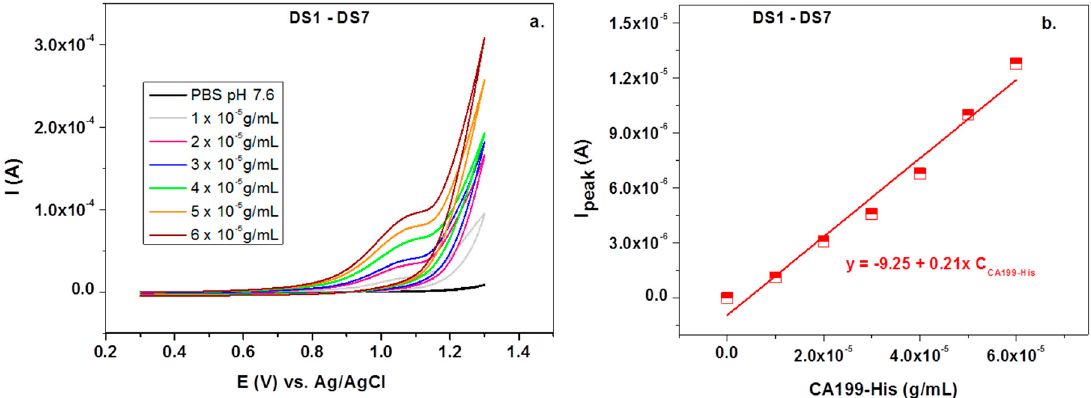
Figure 6. CVs recorded with bare DS electrodes in the presence of CA199-His having various concentrations, from 1 × 10 − 5 to 6 × 10 − 5 g/mL; scan rate 10 mV/s ( a ). Calibration curve obtained with bare DS electrodes for CA199-His ( b ).